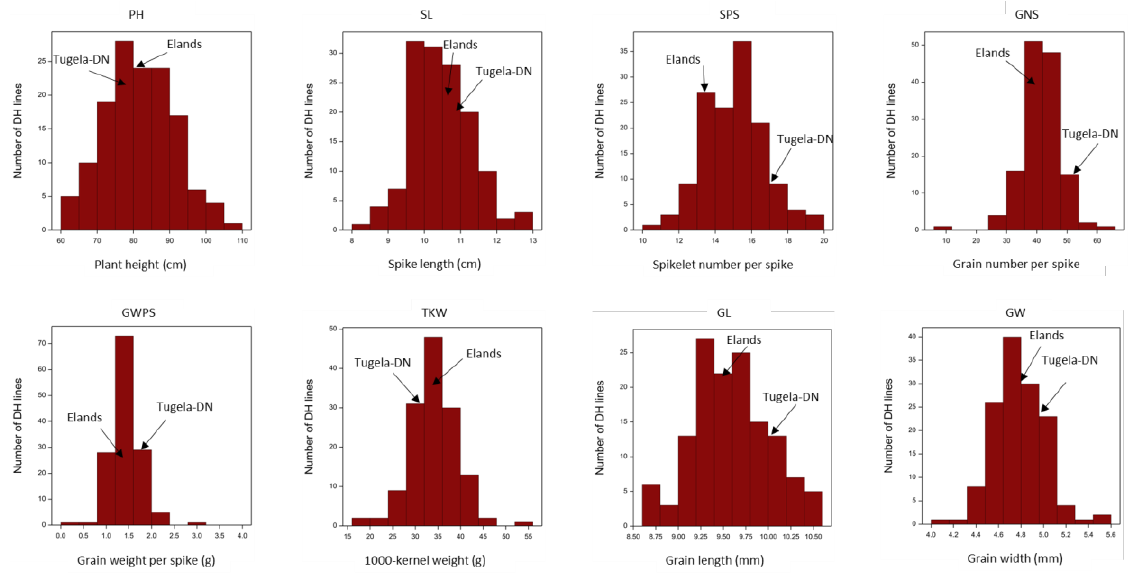
Figure 1. Frequency distribution of agronomic traits in the 138 doubled haploid lines.